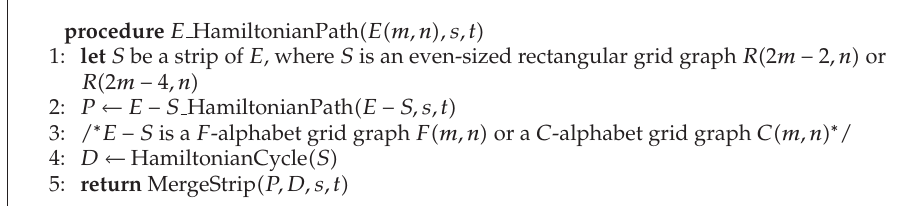
Algorithm 4: The Hamiltonian path algorithm for E -alphabet grid